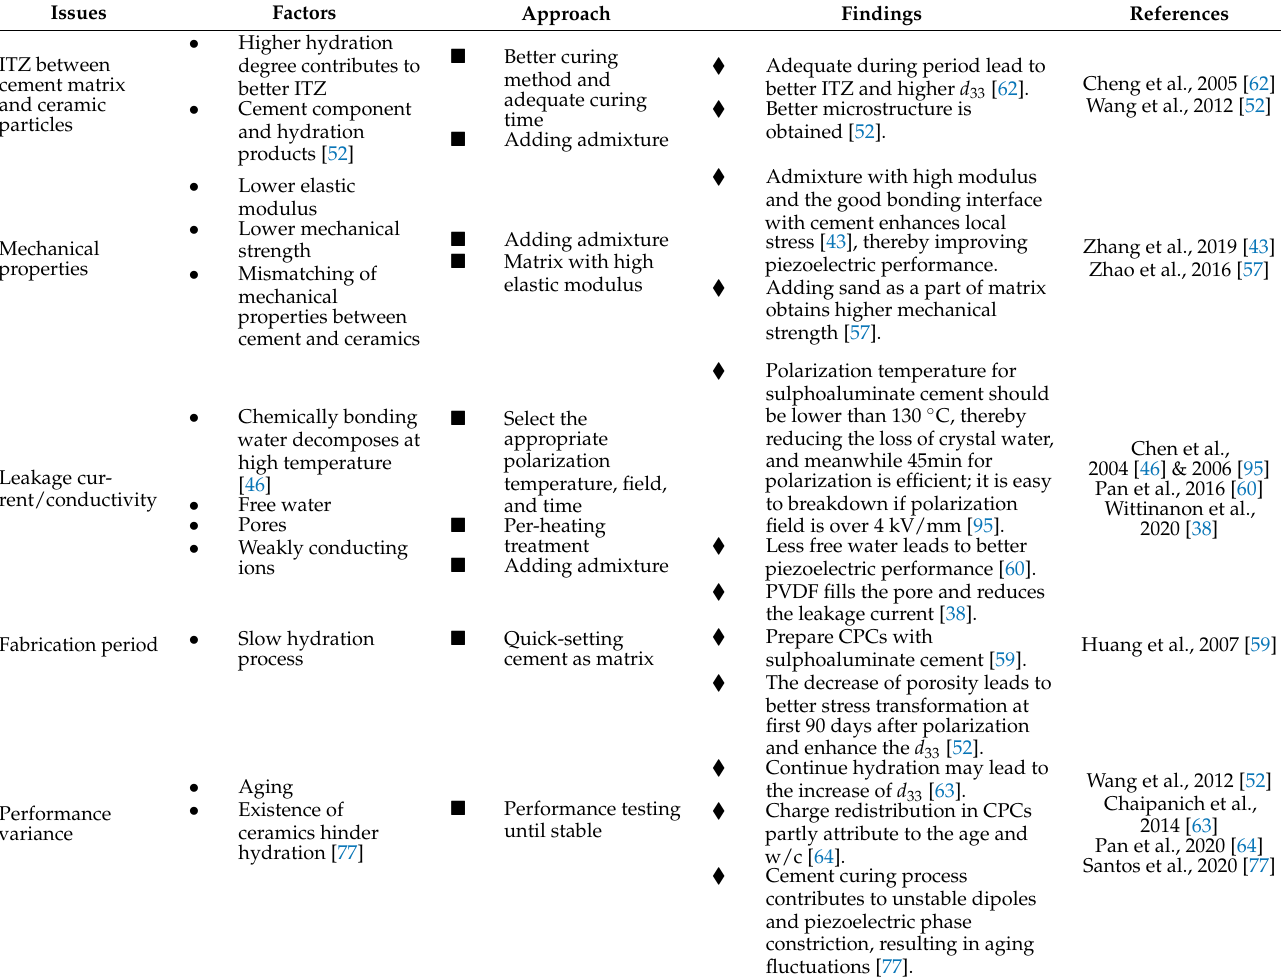
Table 4. Effect of cementitious matrix on the performance of